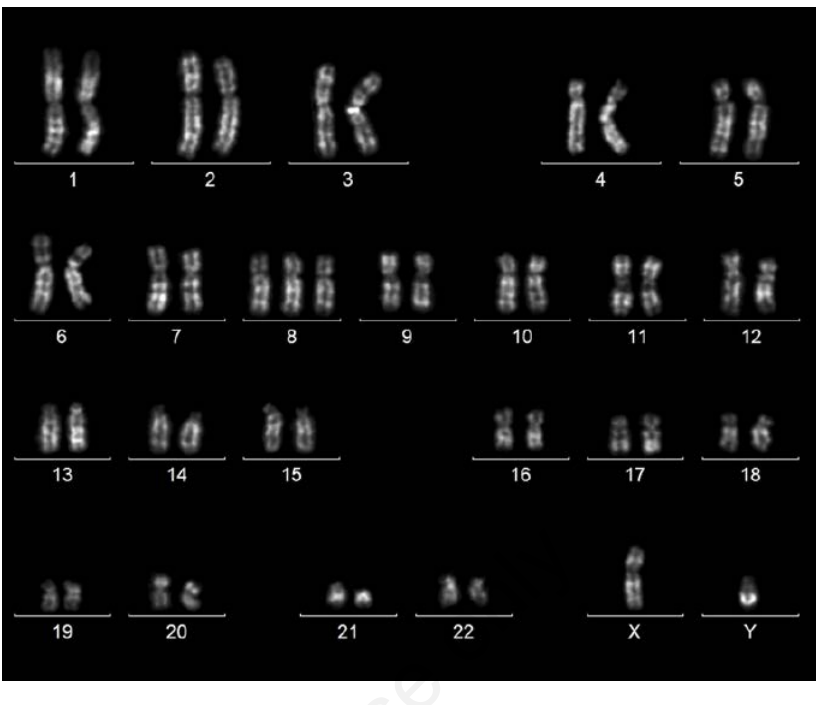
Figure 1. Quinacrine-banded metaphase cell from peripheral blood showing a 47 chro- mosomes male karyotype with trisomy of chromosome 8. Chromosomes 9 and 22 look normal.